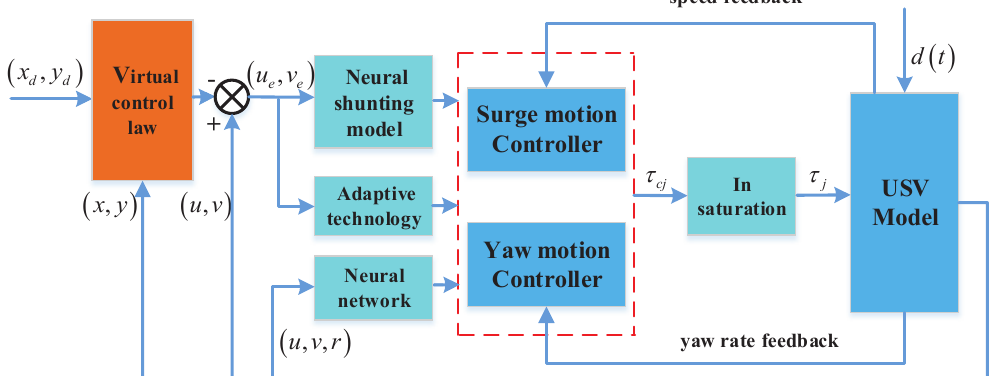
Figure 2. The structure of the proposed adaptive sliding mode control scheme for the underactuated